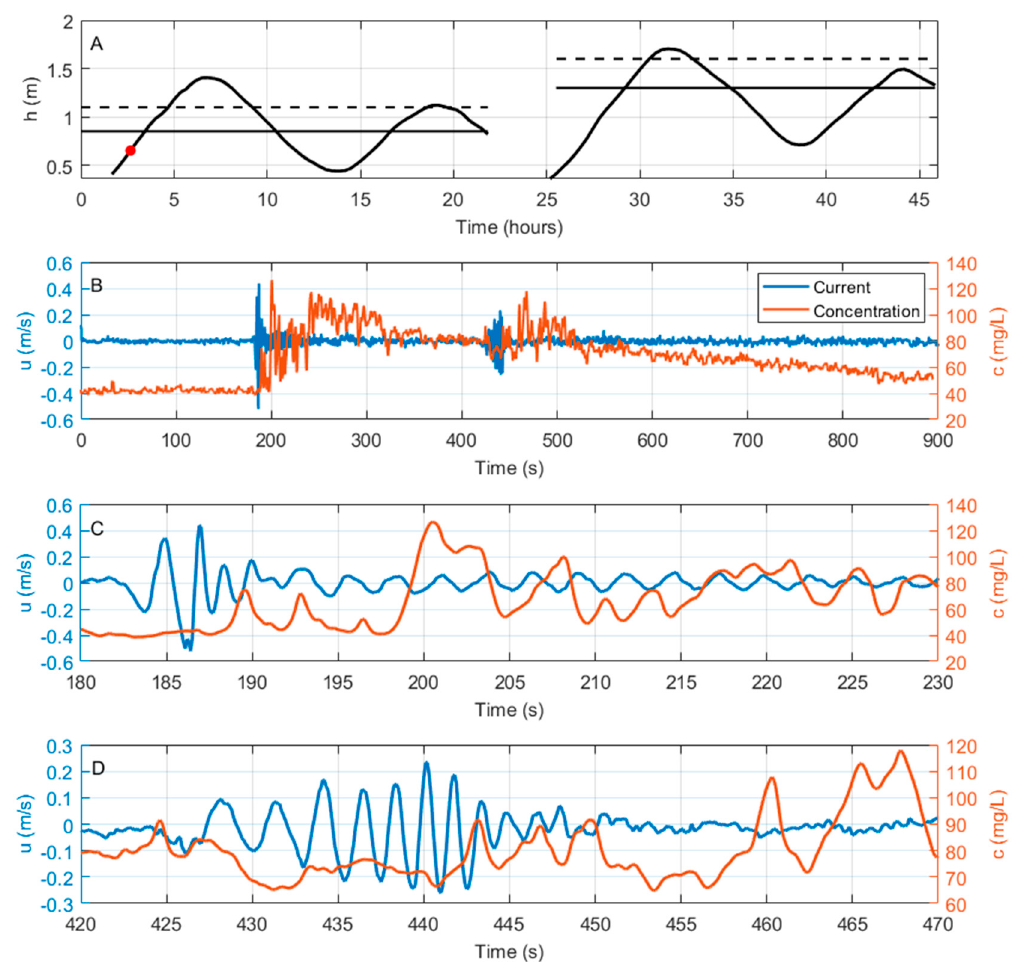
Figure 5. ( A ) Time series of water depth depicting the tidal phase of the first vessel passage (red circle) at Station 1. Dashed and solid horizontal lines represent scarp and marsh elevation as described in Figure 3. ( B ) Time series of the cross-channel current and modeled concentration corresponding to the first burst with vessels at Station 1. ( C ) The first wake event, depicting orbital velocities and the resulting increase in concentration subsequent to vessel passage. ( D ) The second wake event, depicting the orbital velocities and concentration.